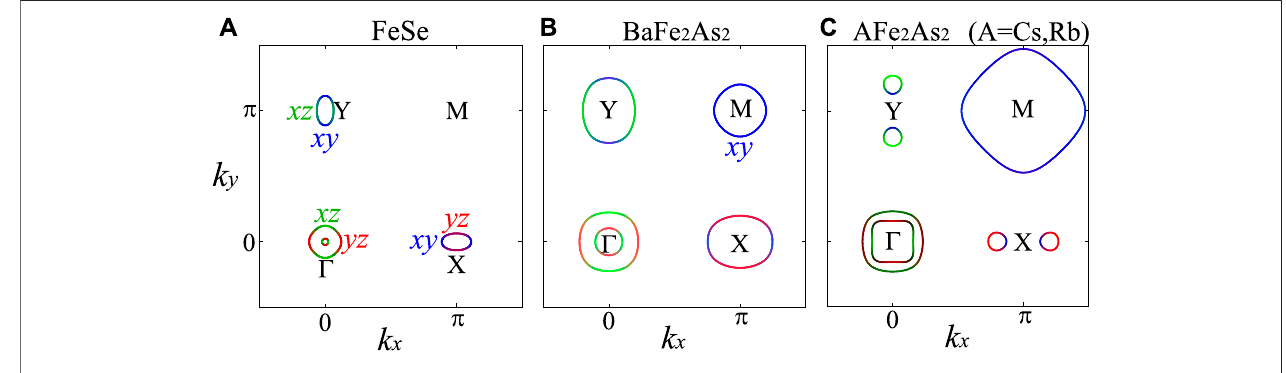
FIGURE2| FSsof (A) FeSe( n d =6.0), (B) BaFe 2 As 2 ( n d =6.0),and (C) AFe 2 As 2 (A=Cs,Rb)( n d =5.5).Thecolorsgreen,red,andblue correspondtoorbitals2,3, and 4, respectively. A variety of nematic/smectic states originates from the characteristic structure of